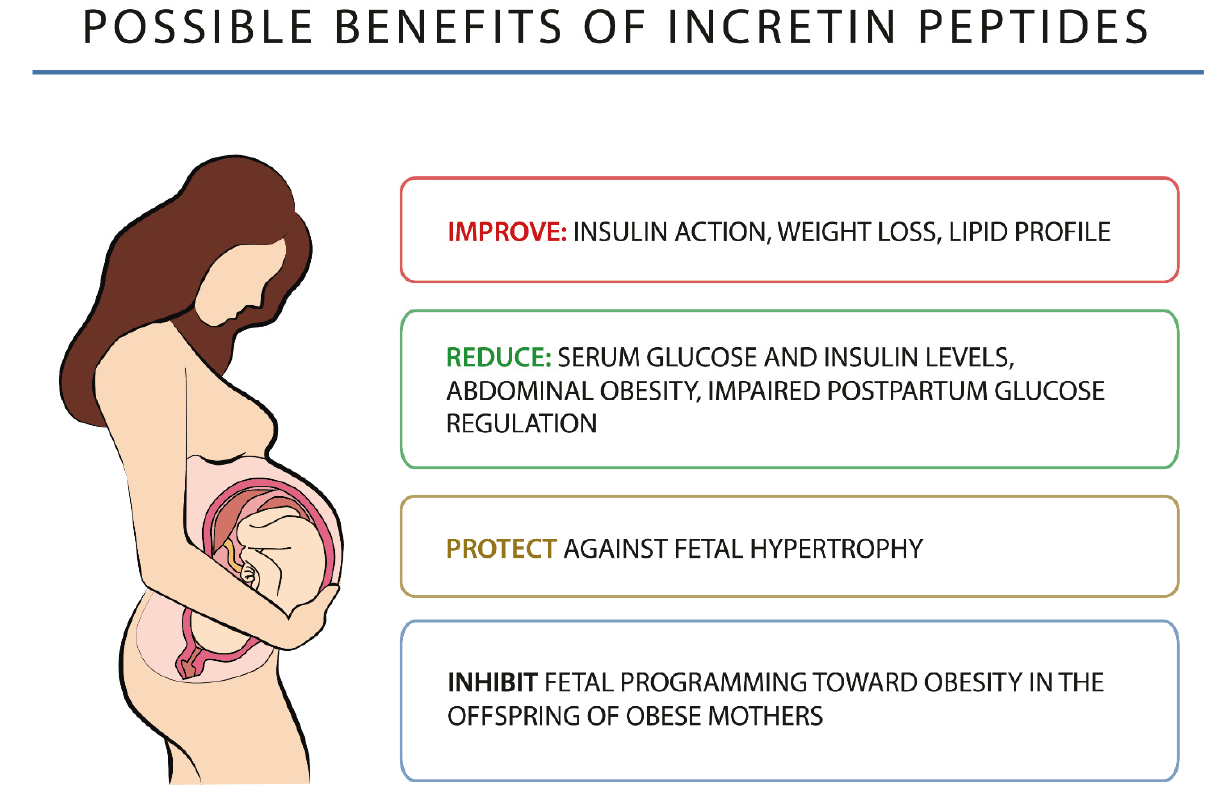
Figure 1. Possible benefits of incretin peptides.